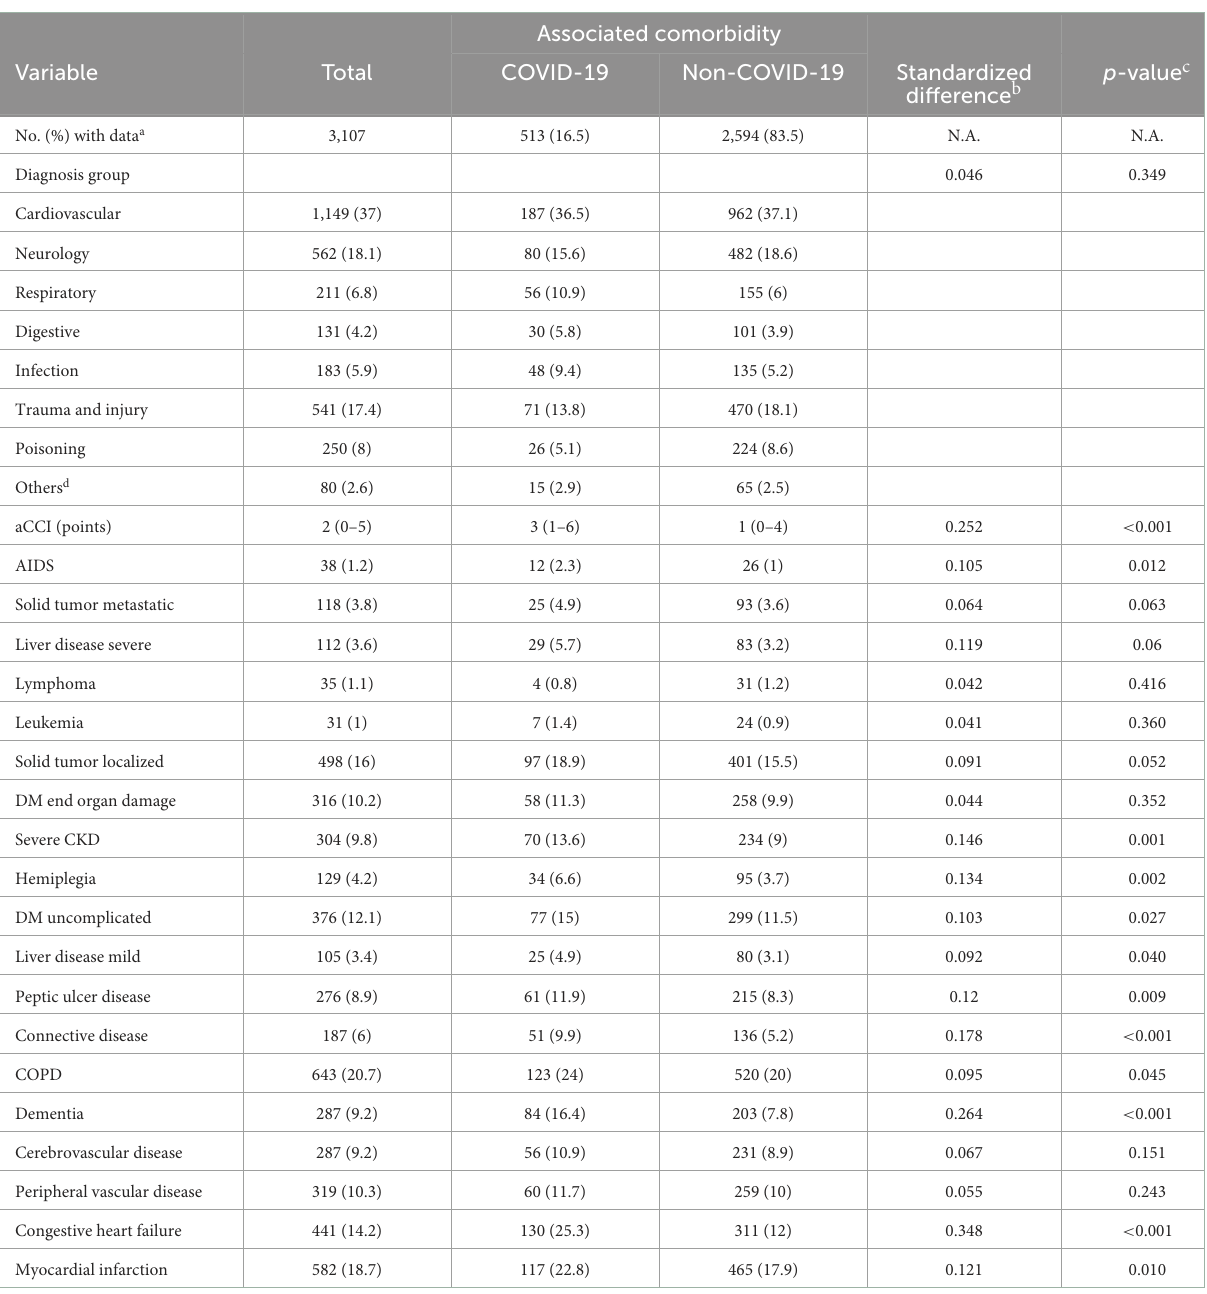
Associated comorbidity